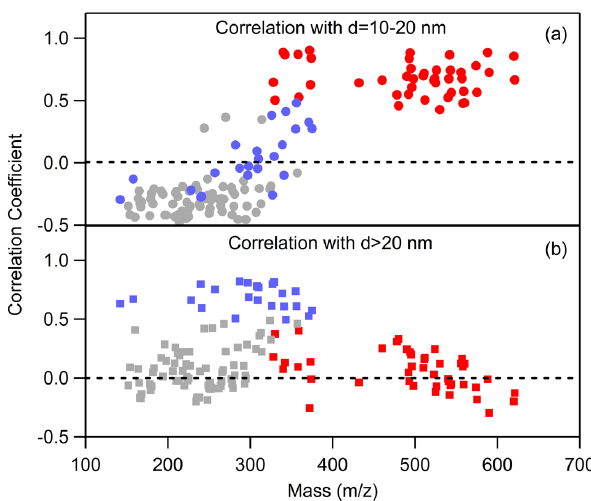
Fig. 2. Coefficients of correlation between gas-phase oxidation products and particles for E1: (a) with 10–20nm particles; (b) with particles larger than 20nm. Color codes: red – Category I products; blue – Category II products; gray – Category III products (see text for the definition of the three categories). The correlations were per- formed between concentrations of products and the number concen- trations of particles for period t = 0–10h in Fig. 1b. The horizontal dash lines indicate zero correlation